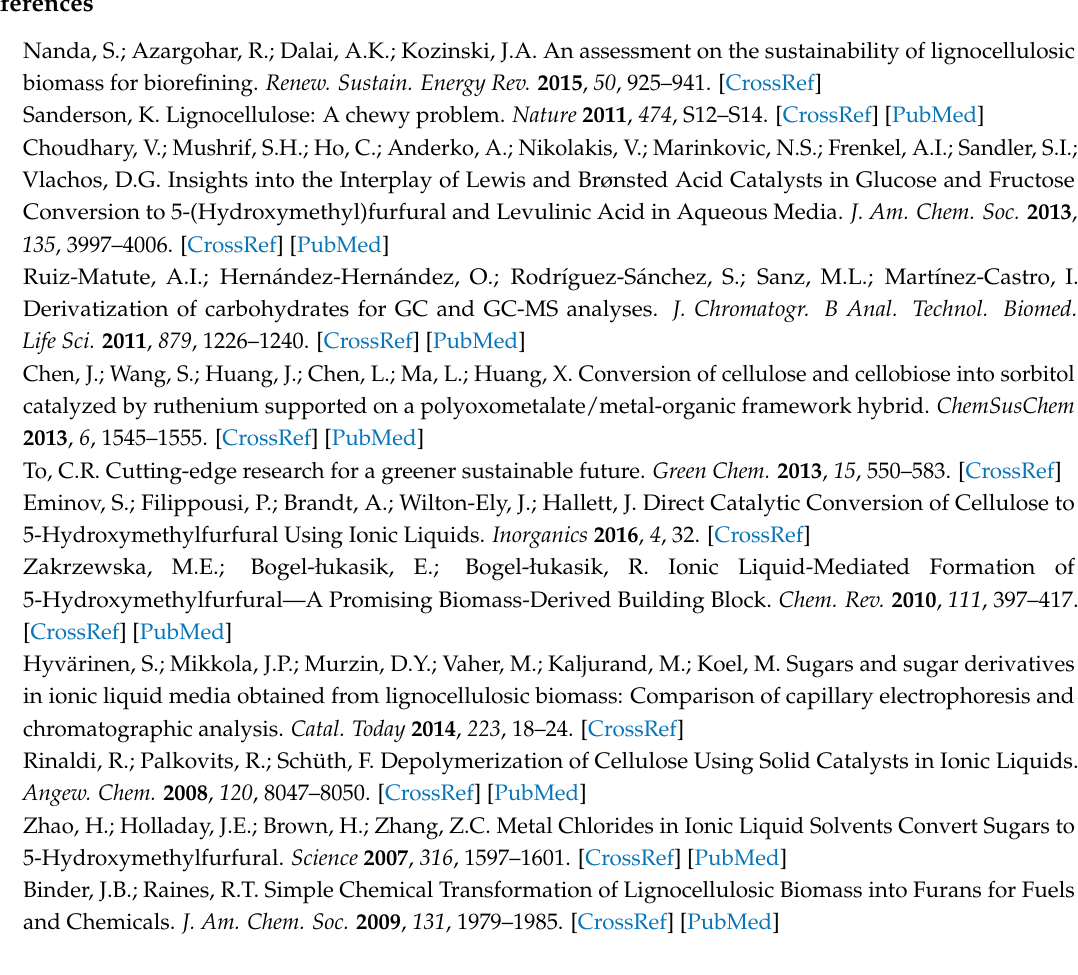
Table S1: Glucose, mannose and HMF contents in cellulose samples degraded in [BMIM]Cl using ZnCl 2 , MgCl 2 , CrCl oxide, Table S3: Conversion of cellulose to glucose, mannose and HMF in [BMIM]Cl at 100 and 120 ◦ C by using POMs based on tungsten oxide, Table S4: Efficiency of cellulose degradation in [BMIM]Cl at 100 ◦ C by using phosphotungstic acid hydrate added 20 min before the substrate, Table S5: Conversion of cellulose to HMF in [BMIM]Cl at 120 ◦ C by using tungsten and molybdenum oxides-based POMs at 5 and 10% substrate loading, Table S6: Efficiency of cellulose degradation in [BMIM]Cl at 100 ◦ C by using phosphotungstic acid hydrate added 3 h after the substrate, Table S7: Conversion of cellulose to glucose, mannose and HMF in [BMIM]Cl at 100 ◦ C in the presence of water (10 wt % of solvent) by using POMs based on tungsten oxide, Table S8: Conversion of cellulose to glucose, mannose and HMF in [BMIM]Cl at 100 ◦ C in the presence of water (10 wt % of solvent) by using POMs based on (a) tungsten oxide, (b) molybdenum